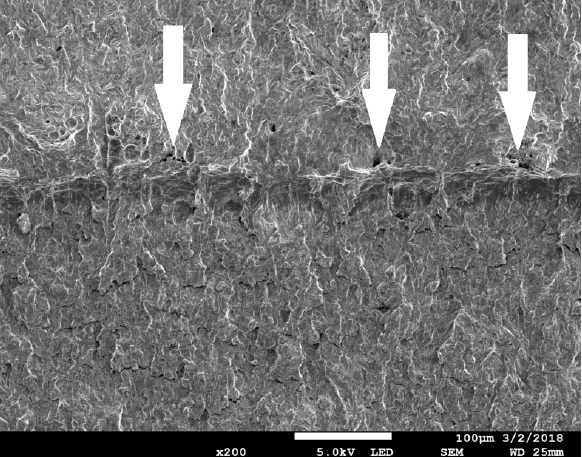
Figure 18. The image of the fracture surface obtained using the scanning microscope. Arrows indicate first voids along the blunted crack tip.